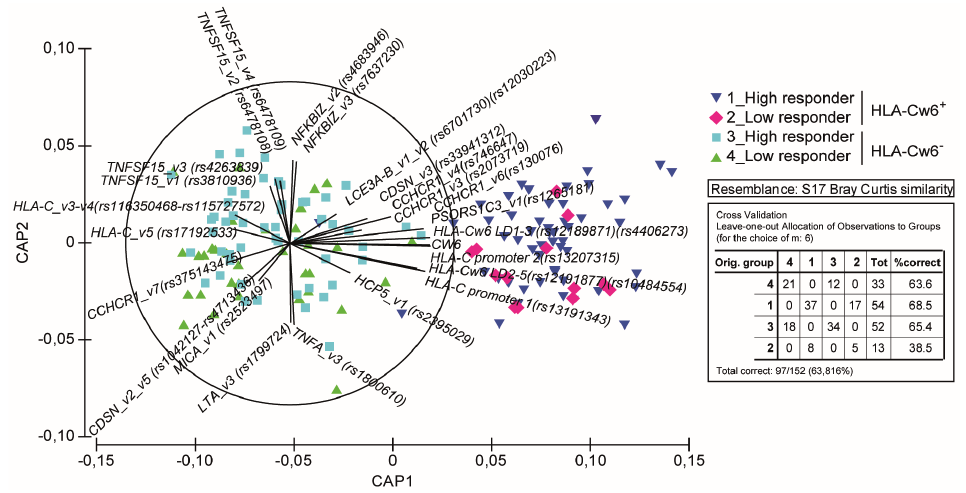
Figure 1. HLA-Cw6 status identifies specific SNP patterns in psoriatic patients associated with clinical response to ustekinumab. Clustering of patients based on presence of SNPs and response to ustekinumab was performed by CAP on a cohort of psoriatic patients ( n = 152), classified as high responders to ustekinumab (PASI90 or PASI100 achievement up to 2-year treatment) or low responders (non-responders or only partially responders for primary failure or responders losing responsiveness over time for secondary failure). CAP ordination plot shows a significant clustering of psoriatic patients belonging to HLA-Cw6 + and HLA-Cw6 − groups along x -axis, and, in particular, to four established subgroups: 1-HLA-Cw6 + high-responders (blue downward triangles), 2-HLA-Cw6 + low-responders (fuchsia diamonds), 3- HLA-Cw6 − high-responders (light blue squares), and 4- HLA- Cw6 − low-responders (green triangles) to ustekinumab. The length of each vector line corresponds to the strength of the correlation and direction for each. Distinctness of the four patient groups was assessed using leave-one-out allocation success. 97 out of 152 (63.82%) patients were correctly allocated. Only the most relevant correlations were considered as valuable and included in the